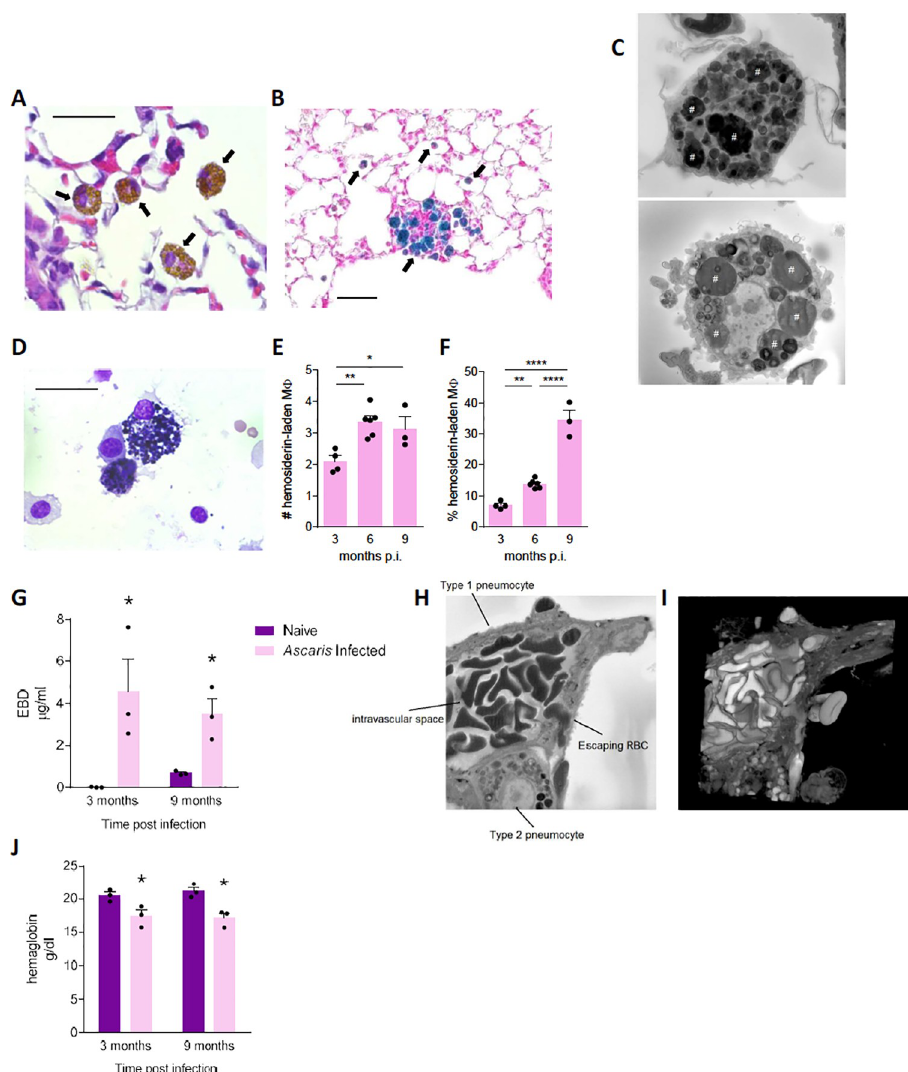
Fig 4. Ascaris induced vascular disruption and chronically induced hemosiderin-laden alveolar macrophages (M F ). Ascaris infected and PBS-challenged, naive mice were euthanized and lungs were harvested for histopathologic analysis at the indicated time interval. (A) Haematoxylin and eosin (H&E), and (B) Prussian blue staining of 5 μ m lung sections. Arrow represents hemosiderin-laden macrophage. (C) Serial block electron microscopy (EM) image of hemosiderin-laden macrophages from lung sections demonstrates engulfed erythrocytes noted by the pound sign. These hemosiderin-laden macrophages were identified at 3 months, 6 months and 9 months post-infection (p.i.). (D) H&E staining of bronchoalveolar lavage fluid (BALF) cells demonstrates hemosiderin-laden macrophage that were also identified at 3 months, 6 months and 9 months p.i.. Absolute cell count (E) and percentage (F) of hemosiderin- laden macrophages from BALF at 3, 6 and 9 months p.i.. demonstrating the % of hemosiderin-laden macrophages increases chronically (G) Pulmonary extravasation of Evan’s blue dye (EBD) at 3 and 9 months p.i. to evaluate vascular integrity and leakage (H) EM image and (I) three-dimensional EM reconstruction of damaged pulmonary vascular structure demonstrating extravasation of the red blood cell (RBC) between a type-1 and type-2 pneumocyte moving from the endovasculature into the alveolar space due to edema. (J) Hemoglobin level from whole blood from infected mice at 3 and 9 months p.i. demonstrate chronic anemia in Ascaris infected mice. (Data are representative of at least two independent